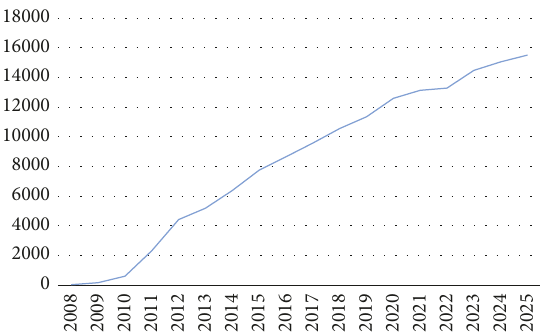
Figure 8: Solar energy supply in France by year, gigawatts per hour. Source: IEA; author‘s calculations.